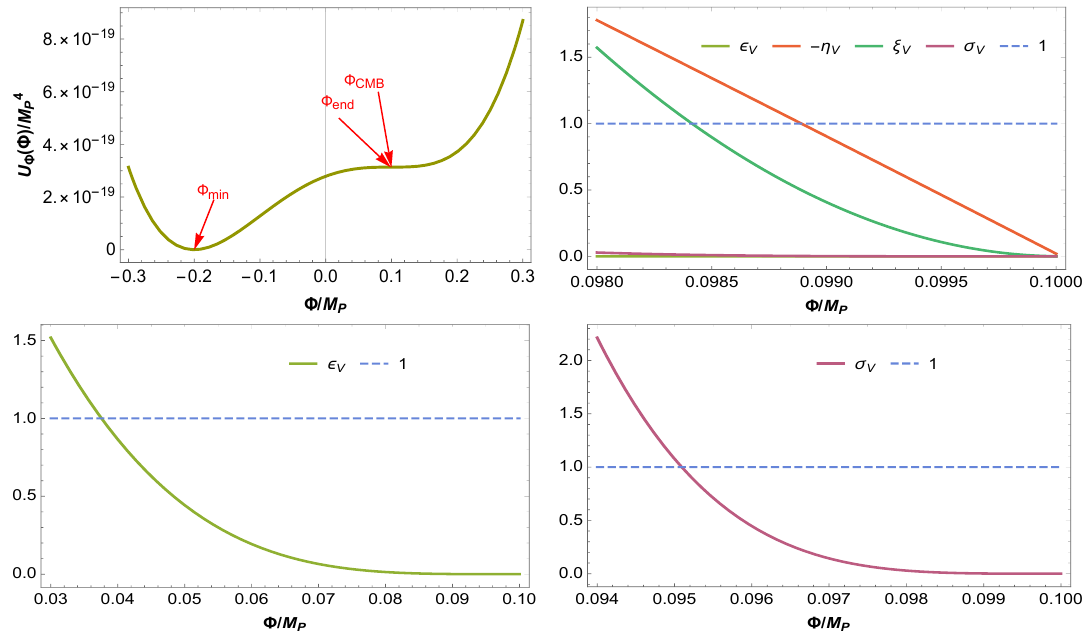
Figure 1. In the top-left panel: normalised inflaton-potential of Model I inflation for benchmark value mentioned in table 2. In the top-right panel: the evolution of inflationary slow-roll parameters ( (cid:15) ) as a function of Φ / M ; second row — left panel: (cid:15) , and second row — right V , − η V , ξ V , σ V P V panel: σ of Model I slow roll inflation as a function of Φ / M are shown separately for benchmark V P values mentioned in table 2. The dashed line is for 1 . As soon as | η 1 , the slow roll inflation V | ∼ ends. From these figures, it is clear that | (cid:15) during the slow-roll V | < | σ V | < | ξ V | < | η V |